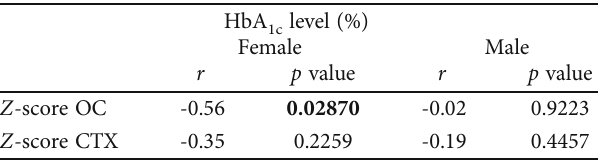
Table 9: Correlations of Z -scores of bone turnover markers and mean HbA1c in girls and